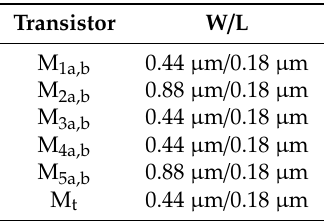
Table 1. Aspect ratios of the transistors.